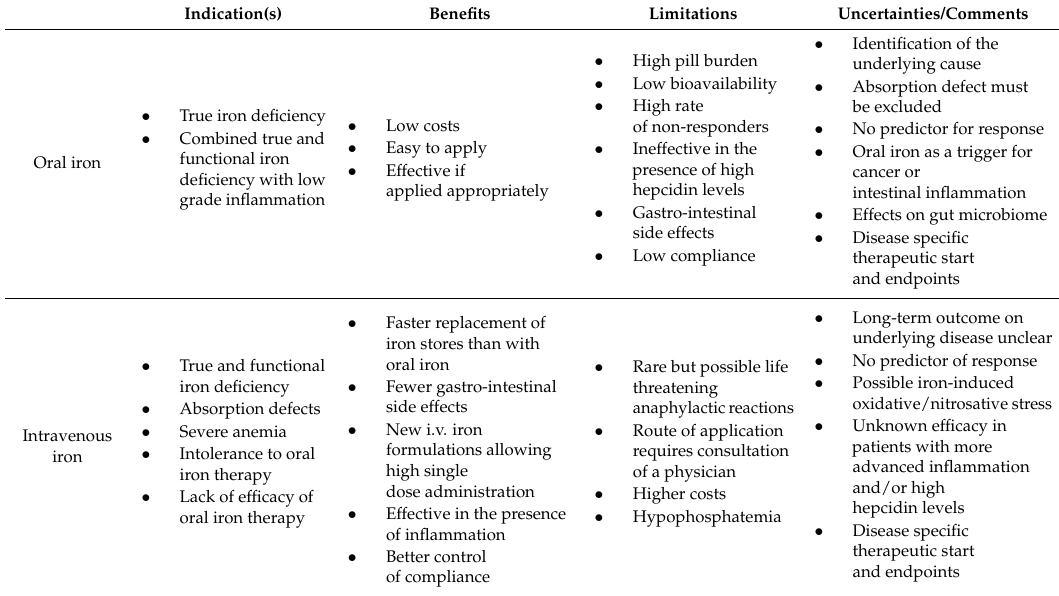
Table 2. Characteristics of oral and intravenous iron